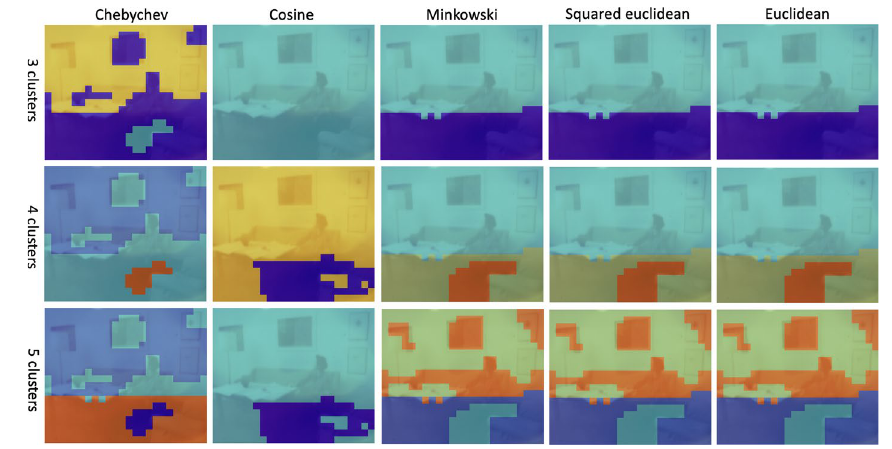
Fig. 7 Segmentation results with different distance metrics, using a grid size of 50 agglomeration